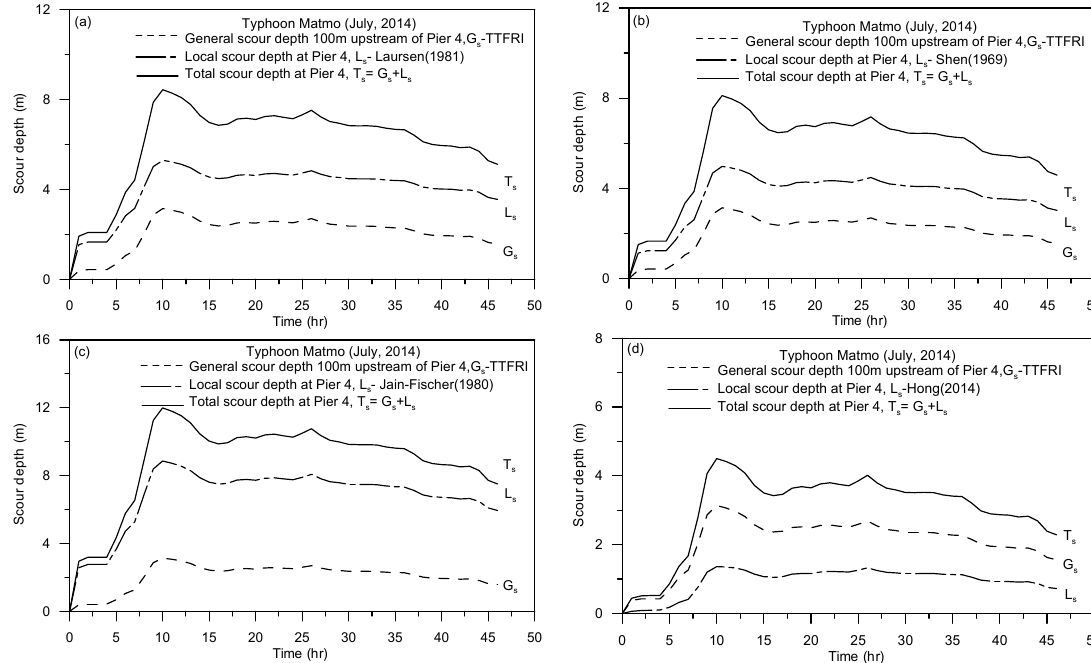
Figure 16. Simulated time variations of scour components during Typhoon Matmo (July, 2014).